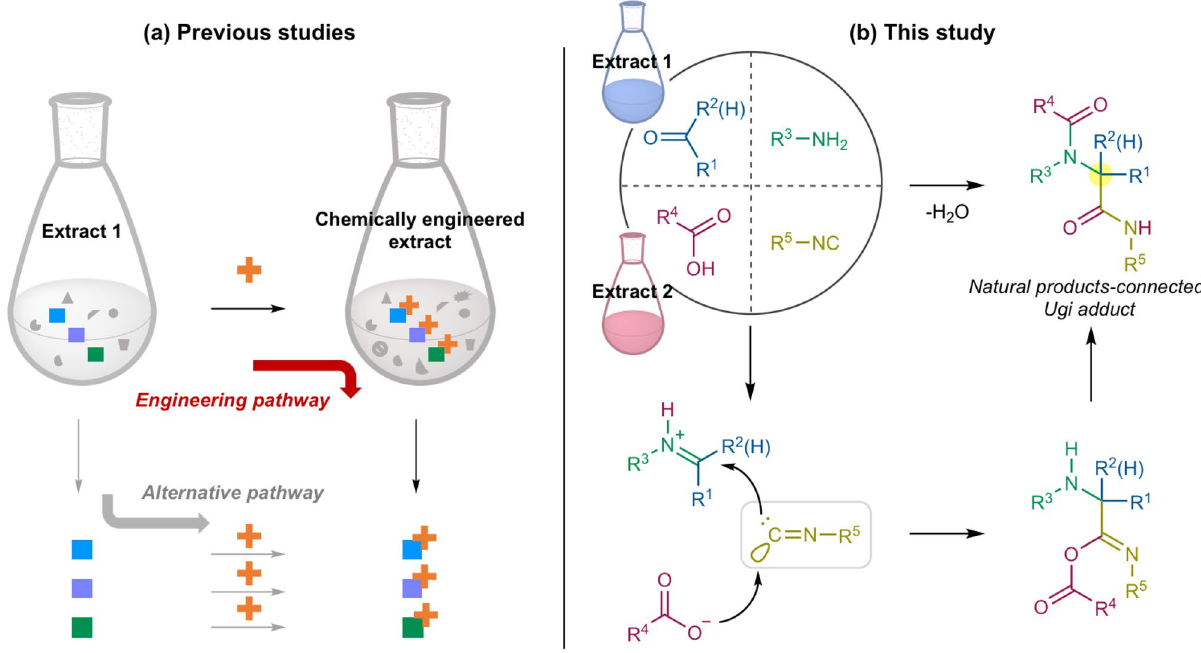
Figure 1. ( a ) Chemical engineering of natural product extracts reported in the literature. ( b ) Chemical hybridization of natural products by the Ugi-4CR in this